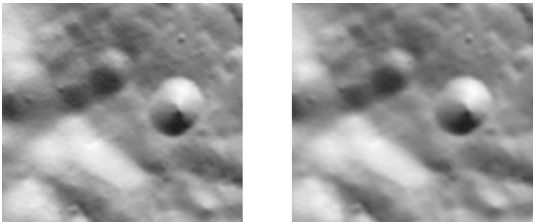
Figure 5. STC simulated stereo pair at LAT: